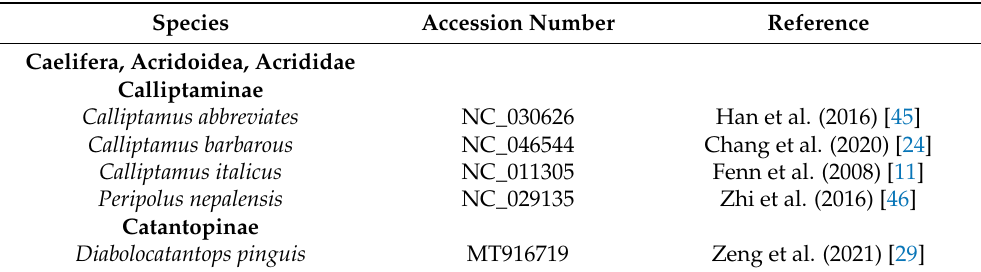
Table 1. Accession numbers and references of the mitogenomes of the species sampled in this